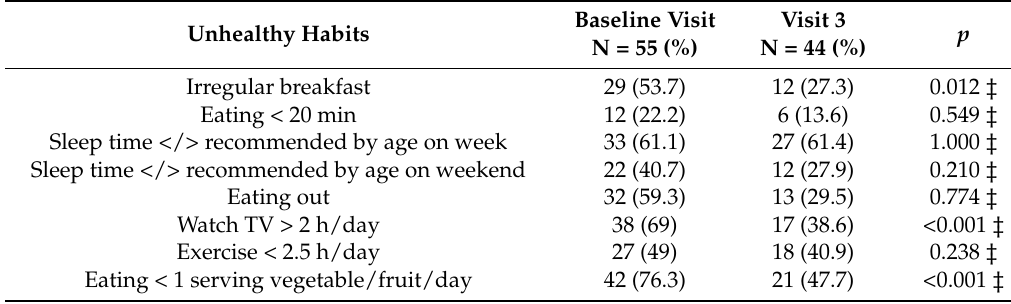
Table 2. Unhealthy habits of children in the baseline and 3rd.